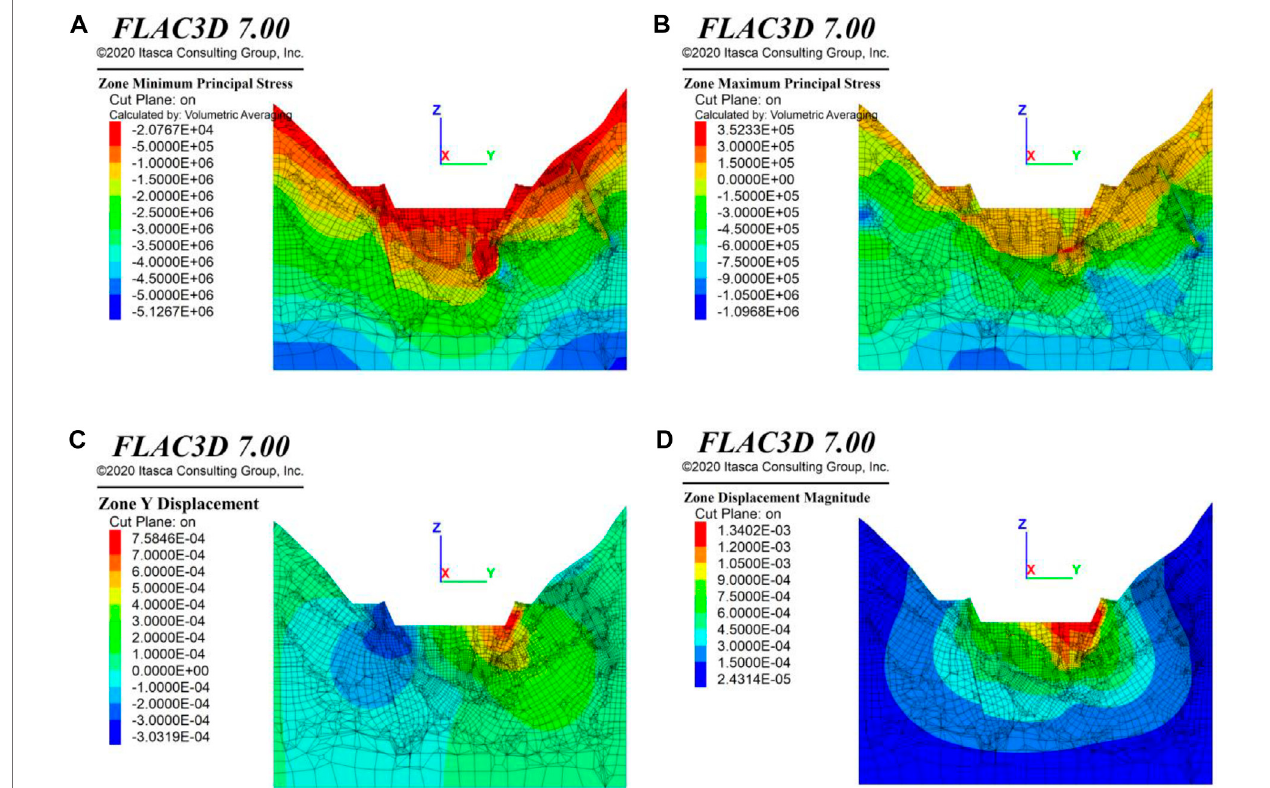
FIGURE 5 | Numerical modelling results at the Pro fi le (Dam 0 + 195.25 m) for the working condition of the frequent fl ood: (A) Major principal stress, (B) Minor principal stress, (C) Displacement transverse the river, (D) Resultant displacement.